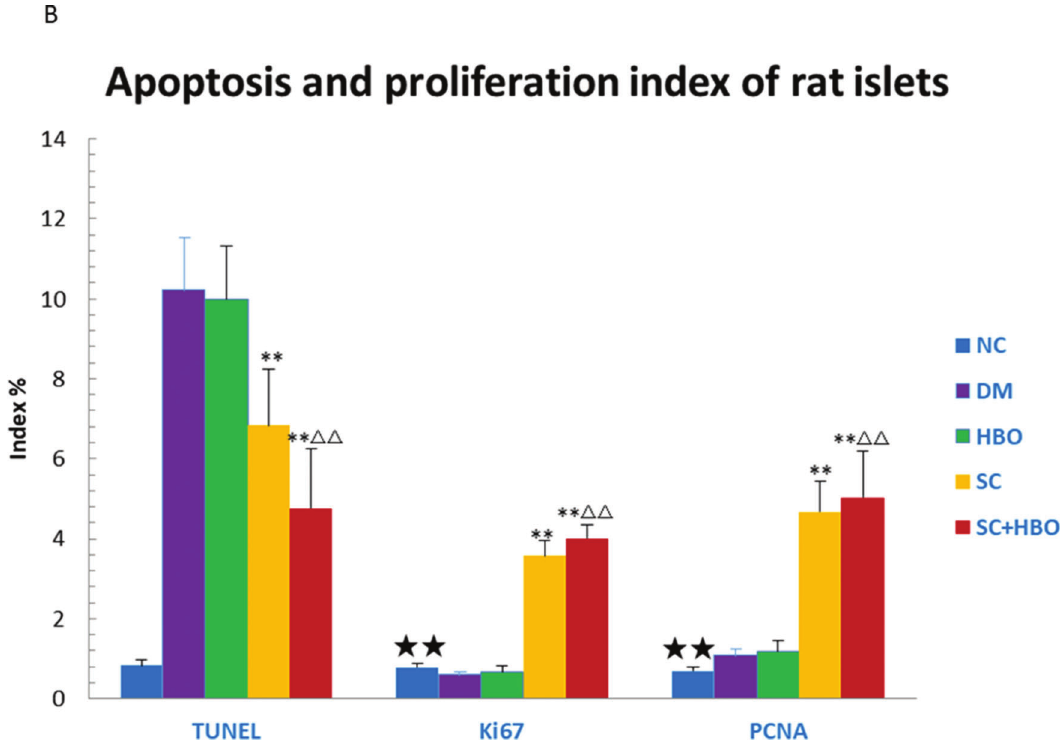
Figure 5 - Apoptosis and proliferation of pancreatic islet cells after 6 weeks of therapy. A. Staining for apoptosis and proliferation analysis in islet cells: The brown cells in the islets shown by red arrows were positively stained cells. TUNEL staining showed that the number of positively stained cells in the islets of DM group was higher than that in the islets of NC group. Positive cells in the islets of SC + HBO and SC groups were lower than those in the islets of DM group. Ki67 and PCNA staining showed that positive cells in islets were slightly higher in DM group than in NC group, and obviously increased in SC + HBO and SC groups as compared with those in DM group. Scale bar: 20 m m, 400 (cid:1) . B. Apoptosis index (AI) and proliferation index (PI) of islet cells: TUNEL AI was lower for SC + HBO and SC groups than that for DM group. The AI for SC + HBO group was lower than that for HBO group; the PI of Ki67 and PCNA was higher for SC + HBO and SC groups than that for DM group, while the PI of SC + HBO group was higher than that of HBO group. ** p o 0.01 vs DM group; WW p o 0.01 vs HBO group; :: p o 0.01 vs each of the other four groups; %% p o 0.01 vs either SC or SC + HBO